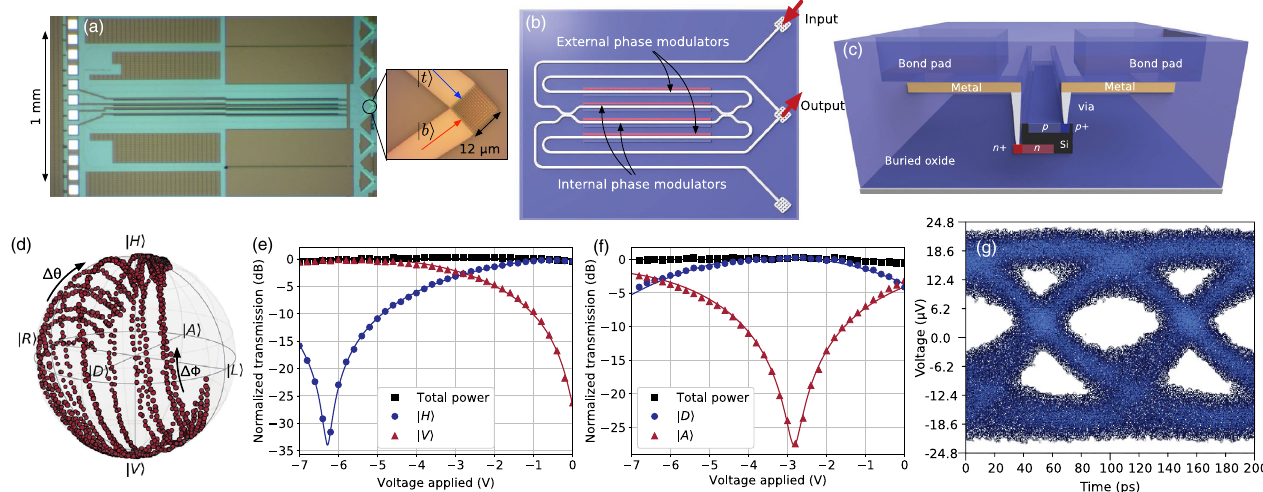
FIG. 1. (a) Optical micrograph of the silicon photonics encoder, along with a scanning electron micrograph of the polarization grating coupler. Only the inner three polarization grating couplers are parts of the encoder operation; the outer two couplers are present to help alignment with a fiber V-groove array. (b) Schematic diagram of the MZM encoder. The device uses two internal and two external electro-optic phase modulators, each of length 1.5 mm. (c) Schematic of the cross-sectional layer stack of the encoder. (d) Bloch sphere representation of the polarization states generated by the encoder as the internal ( Δ θ ) and the external ( Δ ϕ ) phase modulators are biased. (e),(f) Polarization modulation with the silicon photonics polarization modulator as measured in the two relevant bases. Polarization extinction ratio of more than 25 dB can be typically achieved. Negative voltage denotes reverse bias with regards to the doped p - i - n junction. Measurements in the Z basis and X basis are shown in (e) and (f), respectively. (g) Eye diagram of 10-Gbps polarization modulation in the Z basis: on state corresponds to j V i and off state corresponds to j H i